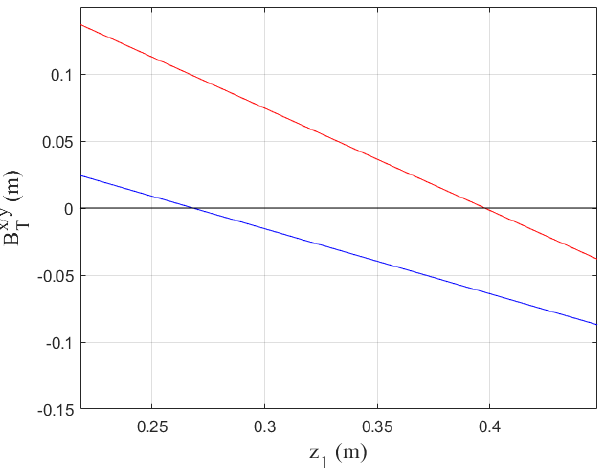
Figure 4. Evolution of the optical transfer matrix parameters 𝐵 𝑇𝑥 (in red) and 𝐵 𝑇𝑦 (in blue) versus the longitudinal position 𝑧 1 of the particle.